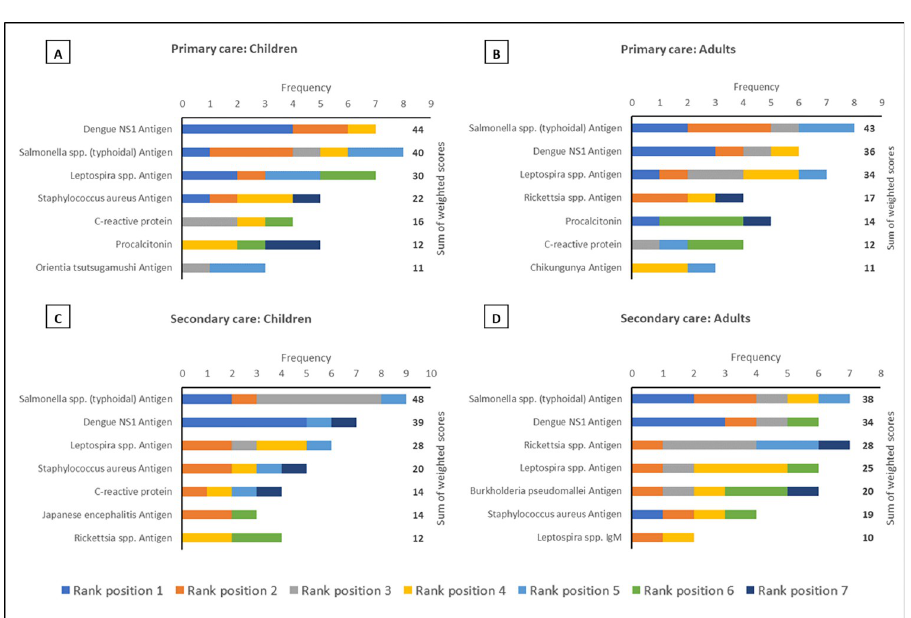
Fig 2. The top seven analytes, in descending order of priority based on sum of weighted scores, which should be considered for inclusion in multiplex lateral flow rapid diagnostic tests for acute non-malarial fever using fingerprick blood as the test substrate, in the following patient populations in Maritime Southeast Asia: (A) Children presenting to primary care settings (B) Adults presenting to primary care settings (C) Children being admitted to secondary care settings (D) Adults being admitted to secondary care settings. Children were defined as patients aged > 28 days and < 15 years. An analyte in rank position 1 was weighted seven times more than an analyte in rank position 7; the maximum sum of weighted scores per analyte was